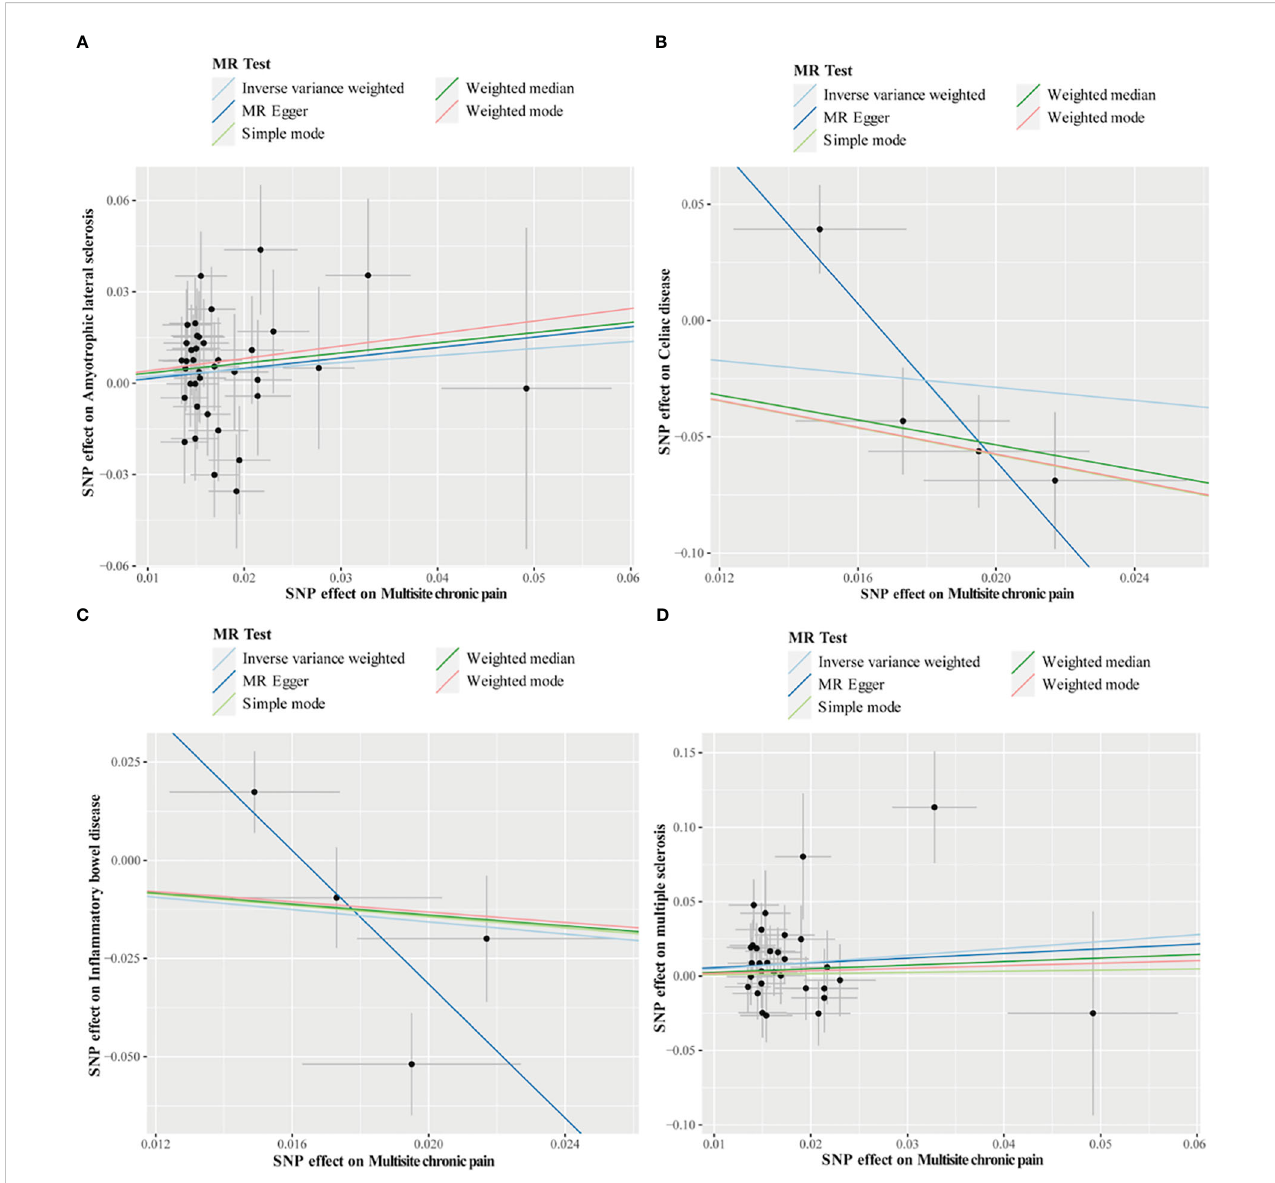
FIGURE 3 Scatter plots of MR analysis. The slope of each line corresponding to the estimated MR effect based on various models. (A) multisite chronic pain on amyotrophic lateral sclerosis, (B) multisite chronic pain on celiac disease, (C) multisite chronic pain on in fl ammatory bowel disease, (D) multisite chronic pain on multiple